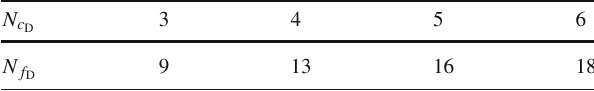
, N Table 2 Values of N c f D which lead to asymptotically free D ) theories. It is important to stay well below these values in SU ( N c D order to remain within the QCD-like scenarios of current interest to